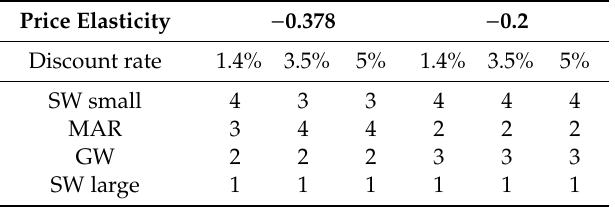
Table 5. Ranking order of net present values for analyzed measures when using two di ff erent price elasticities of water demand and three di ff erent discount rates. Rank 1 = highest net present value (NPV) and Rank 4 = lowest NPV (mean values). The risk reduction of all scenarios combined are used in these calculations.